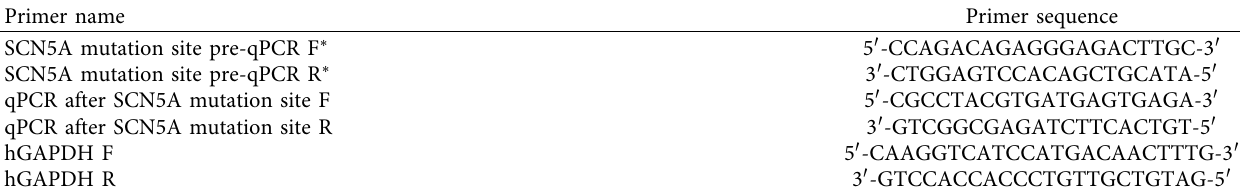
Table 1: Design of reverse transcription primers for qPCR detection of SCN5A in peripheral